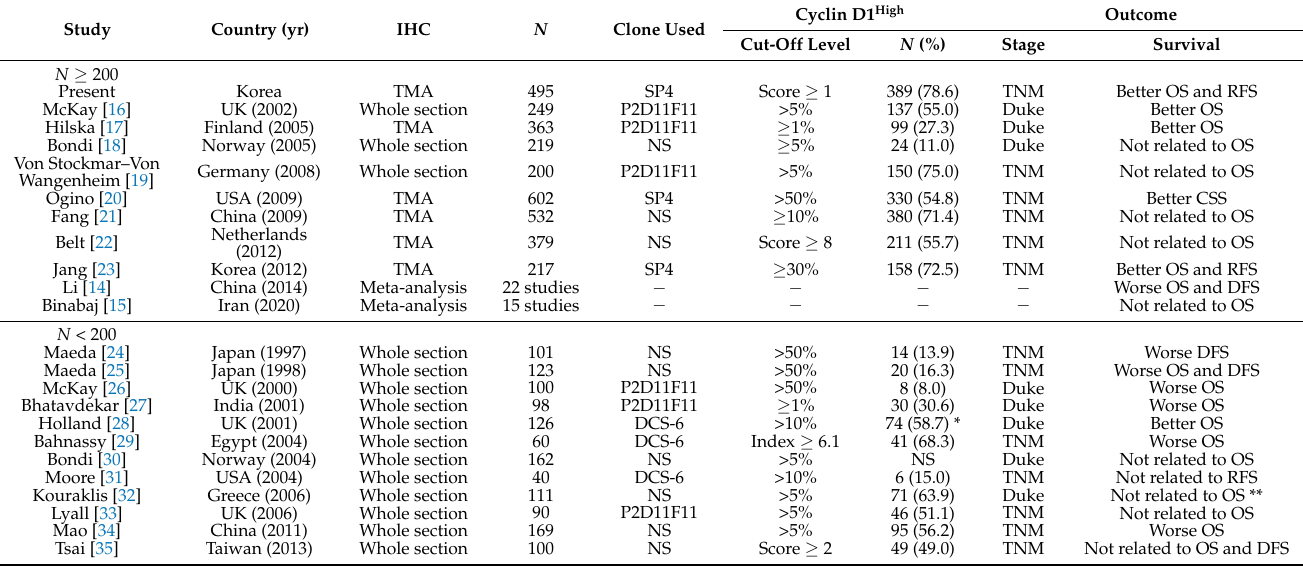
Table 1. Previous studies of cyclin D1 expression in